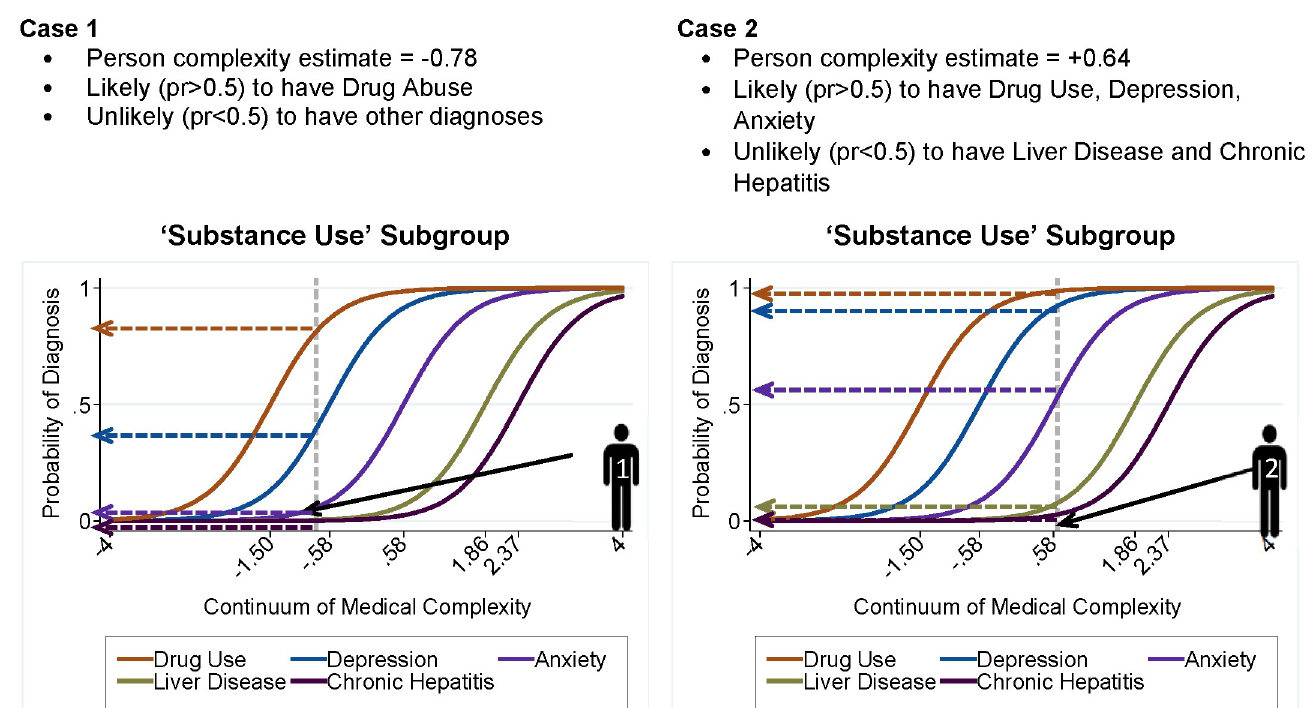
Fig 1. Interpreting IRT item characteristic curves (ICC) as defined by medical diagnoses for two example patients from the same subgroup. This figure illustrates fundamental aspects of IRT models using two hypothetical patients from the same subgroup. Medical conditions and persons are each given estimates which place them on the construct, medical complexity; estimates represent amount of complexity captured by the medical condition or person. Here, the two patients represent low and high amounts of complexity and consequently, which medical conditions they were likely to have given their levels of complexity.